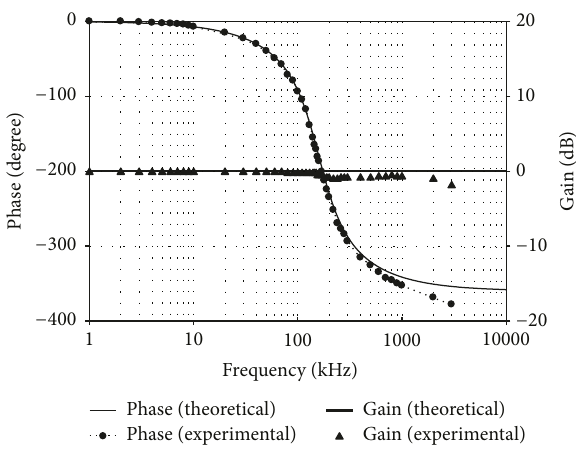
Figure 4: Experimental phase and gain response of all-pass